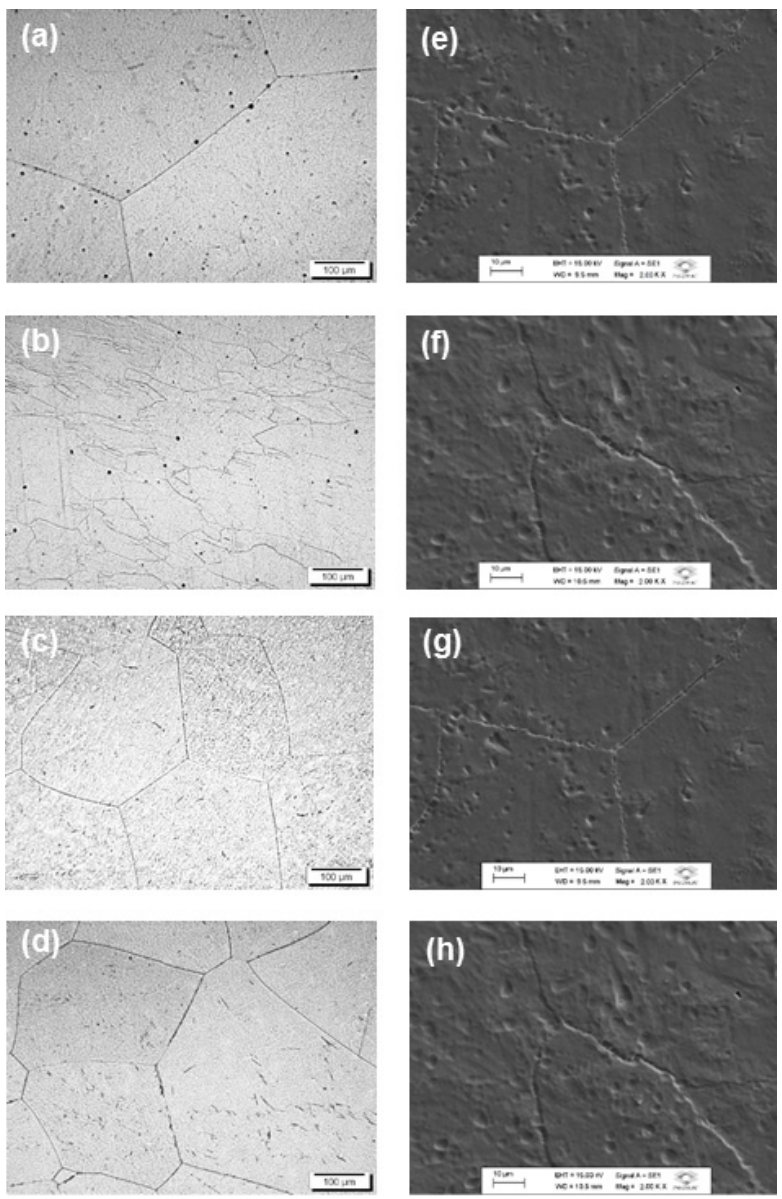
Figure 3. Optical micrographs of the Ti-5Mn-10Mo alloy after homogenization ( a ), hot-rolling ( b ), and solution ( c ) and annealing ( d ) treatments. SEM micrographs of the Ti-5Mn-10Mo alloy after homogenization ( e ), hot-rolling ( f ), and solution ( g ) and annealing ( h ) treatments.